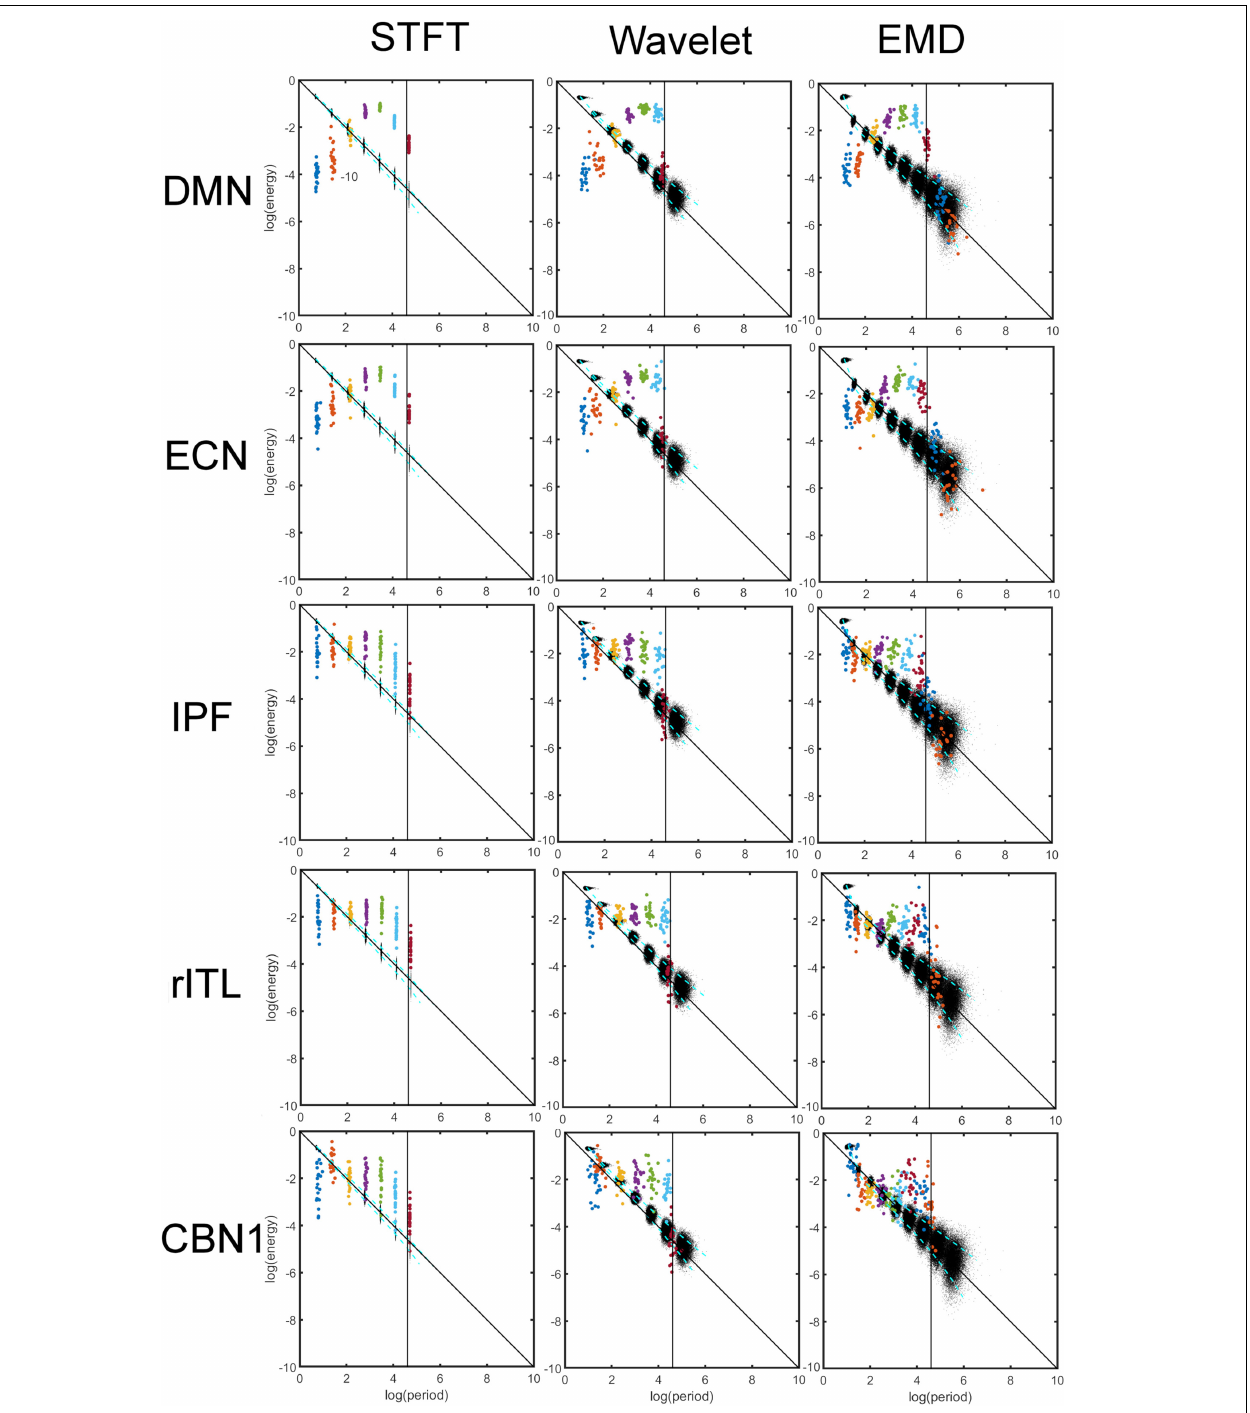
FIGURE 5 | Comparison of energy and period profiles using three different analysis methods (Short-Time Fourier Transform (STFT), Maximal Overlap Discrete Wavelet Transform (MODWT), Empirical Mode Decomposition (EMD)) applied to five different resting-state networks (Default Mode Network (DMN), Executive Control Network (ECN), Inferior Prefrontal Network (IPF), right Inferior Temporal Network, Cerebellar Network 1 (CBN1). As before (see Figures 2 , 4 ), the black dots represent a data decomposition of white Gaussian noise. Dots of the same color correspond to the same component of the decomposition, i.e., dyadic frequency interval decomposition for STFT, detail level decomposition of the wavelet transform, and intrinsic mode function (IMF) decomposition for EMD. There are 22 dots with the same color corresponding to the 22 subjects studied. The vertical line corresponds to the cut-off frequency of 0.01 Hz, and information to the right of this line (i.e., frequencies lower than 0.01 Hz) is of no interest in this study. Note that these 5 networks were chosen to be representative networks of the clusters 1 to 5 in Figure 10